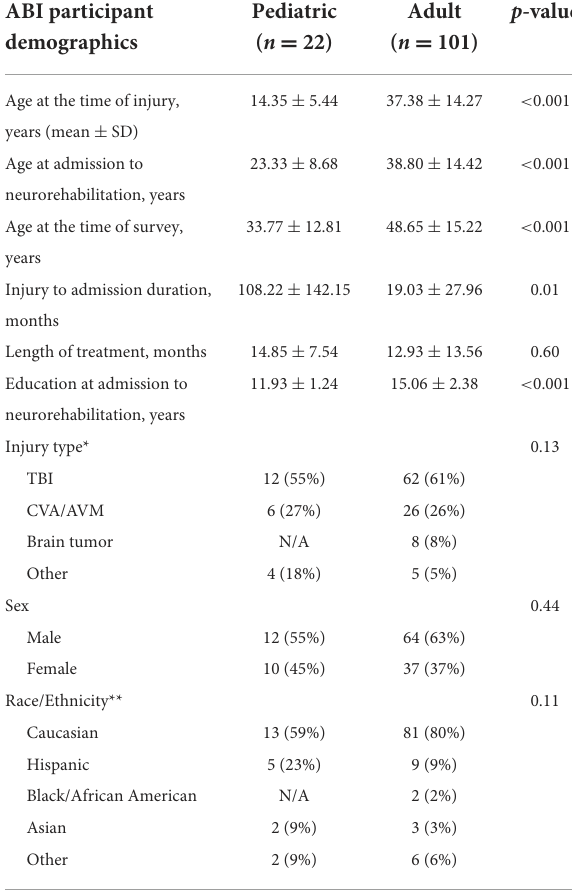
TABLE 1 Demographics based on onset of injury type ( n =